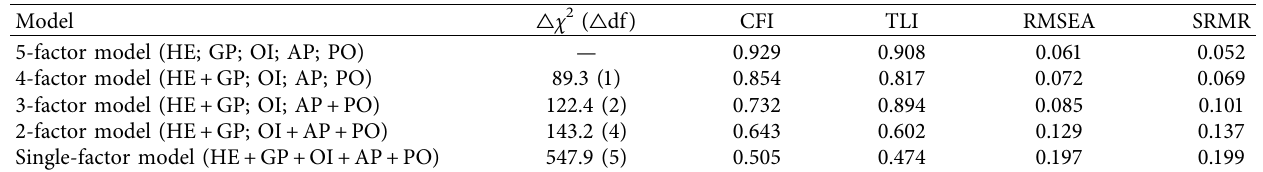
Table 4. The talent ecological environment of the host country has a significant influence on the returning inten- tion of the overseas talents ( − 0.227, 1% level of significance),